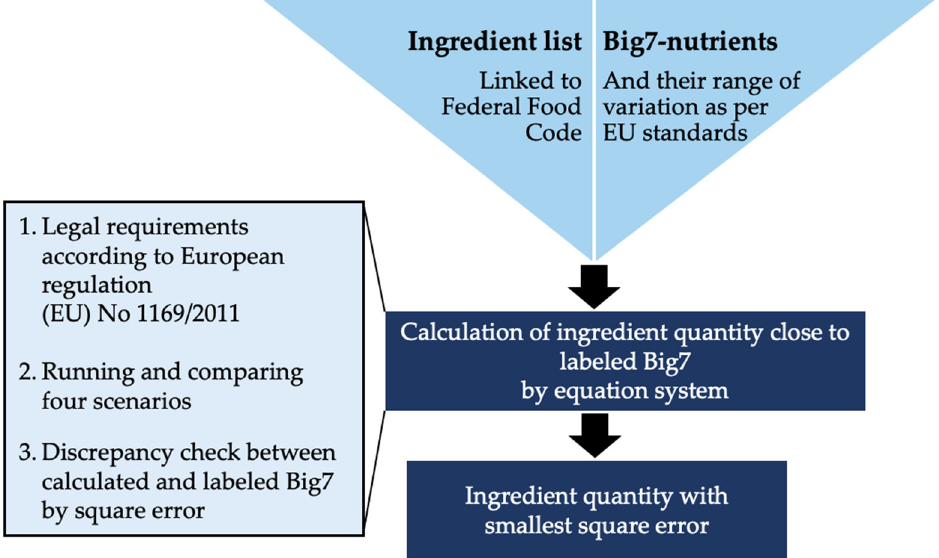
Figure 1. Calculation of ingredient quantity. Schematic presentation of the determination of ingredient proportions using the algorithm developed by Bohn et al. [31].